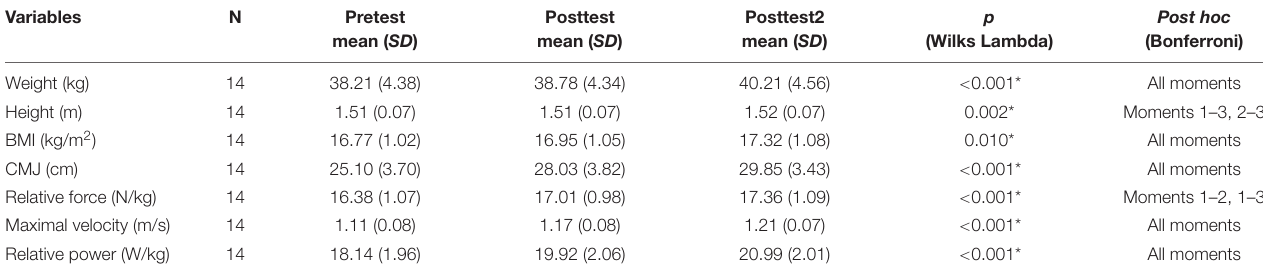
TABLE 4 | Intervention group, intragroup comparison (3 evaluation